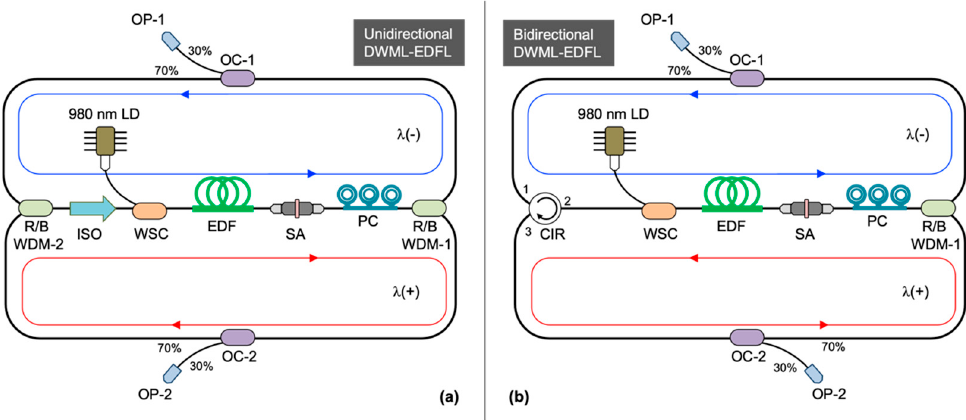
Figure 3. Experimental setup of ( a ) unidirectional and ( b ) bidirectional